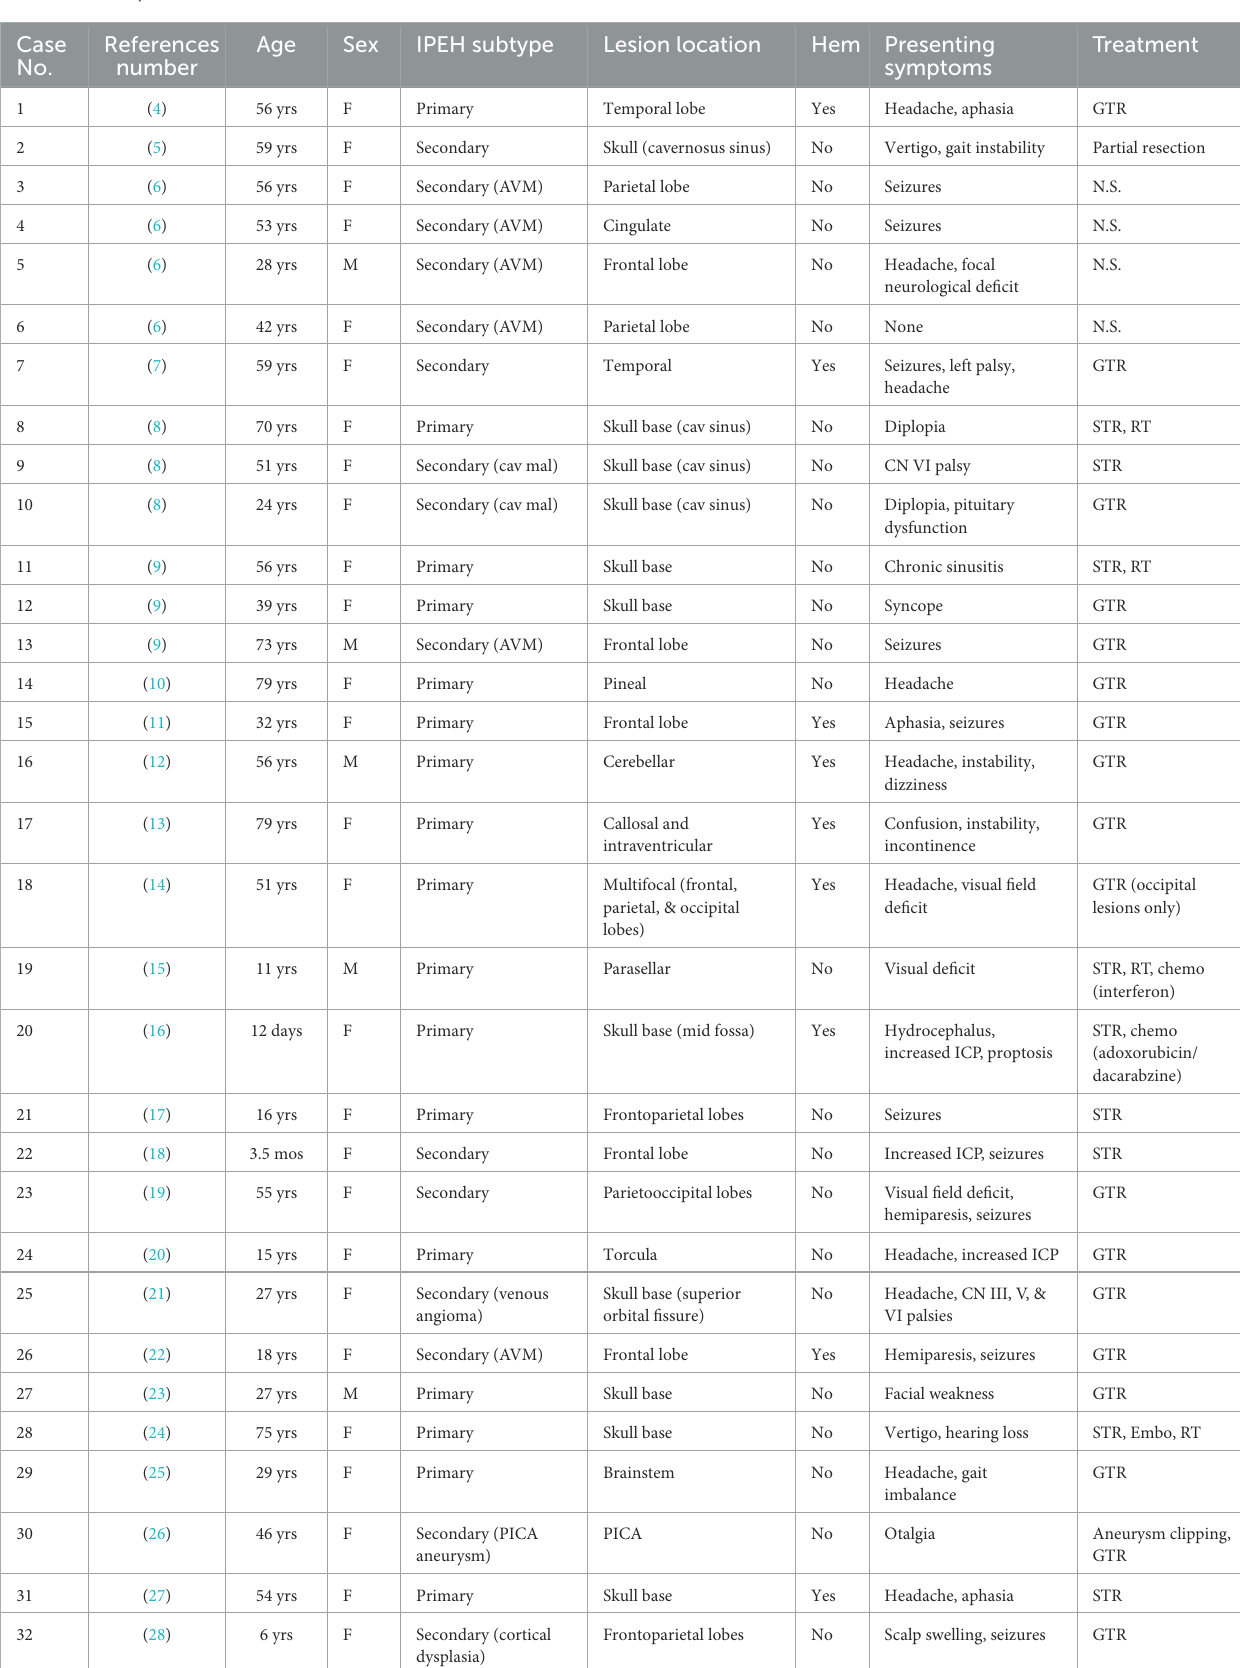
TABLE 2 Case reports of intracranial IPEH/Masson’s tumor review. Case